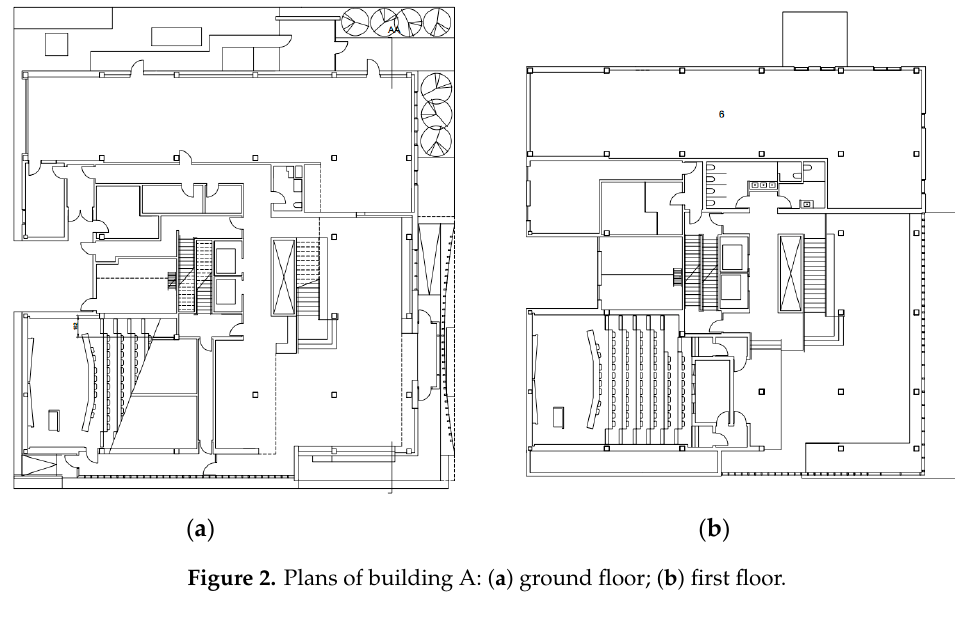
Figure 1. Longitudinal cross section of building A.